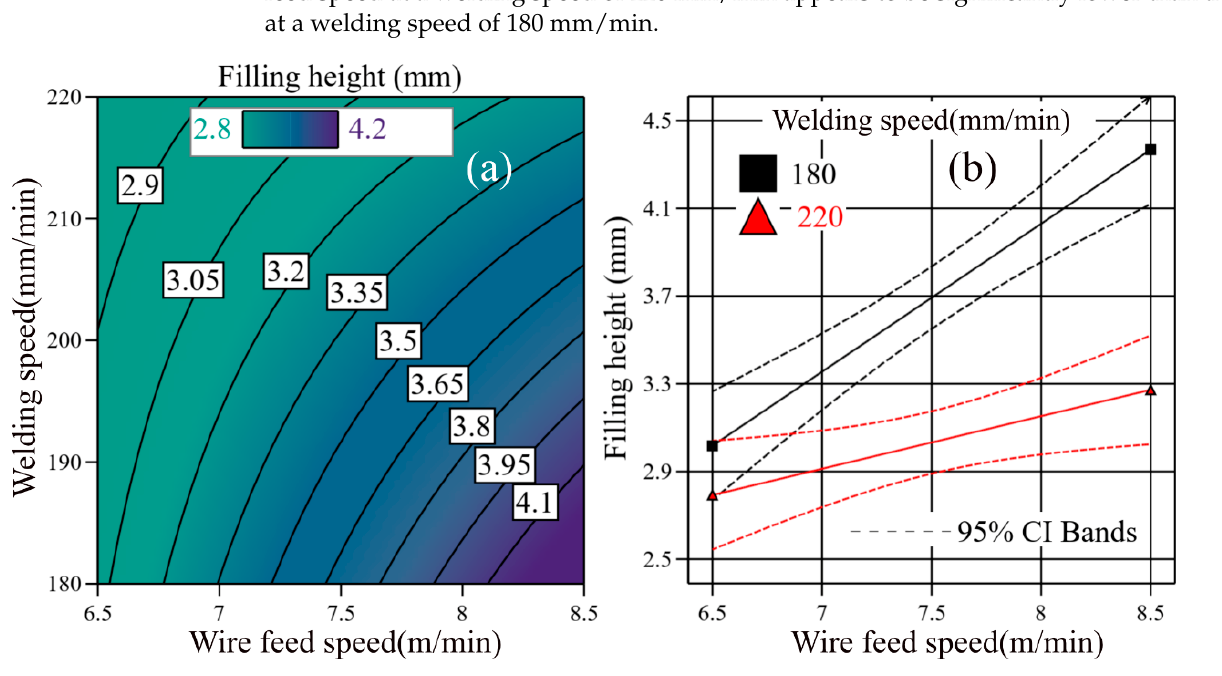
Figure 8. Size of heat-affected zones: ( a ) widths of HAZs obtained by the calculated models; ( b ) interaction of welding speed and wire feed speed on the width of the HAZs.